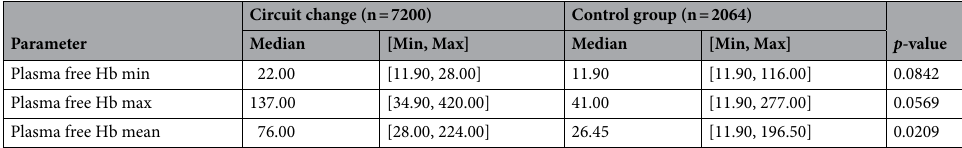
Table 4. Clotting parameter comparisons between circuit change and no-circuit change values. n = 9264 data time points. Hb Hemoglobin, Max maximum, Min